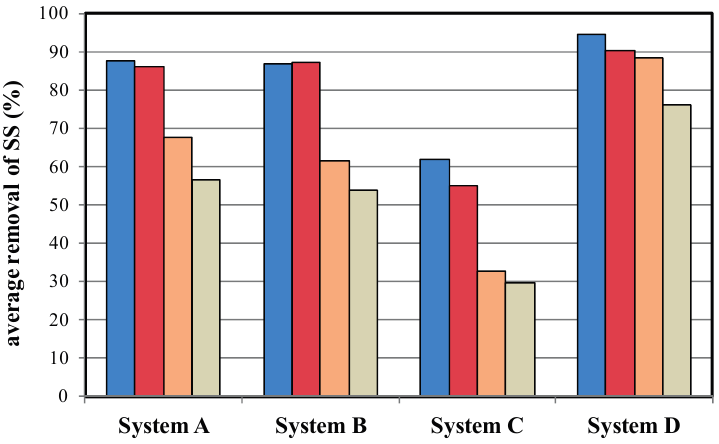
Figure 6. Average SS removal efficiency of the four MSL samples under various HLR